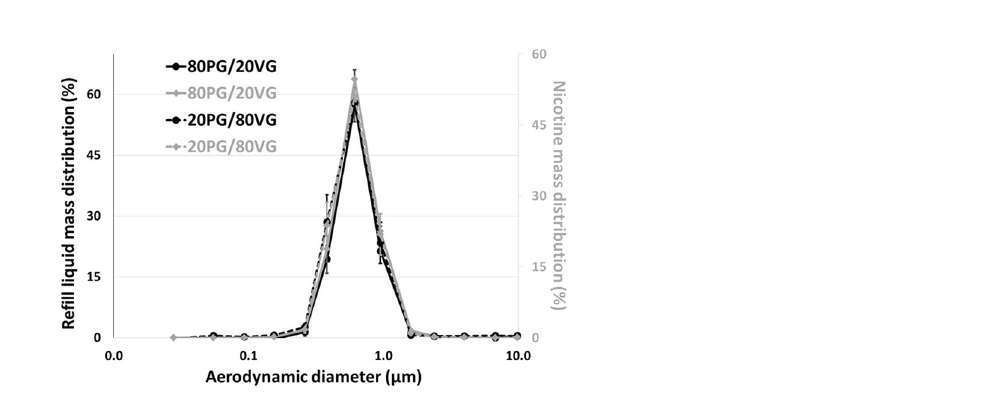
Figure 1. Scheme of the experimental set-up for the particle sizing distribution of aerosol generated by ENDS.